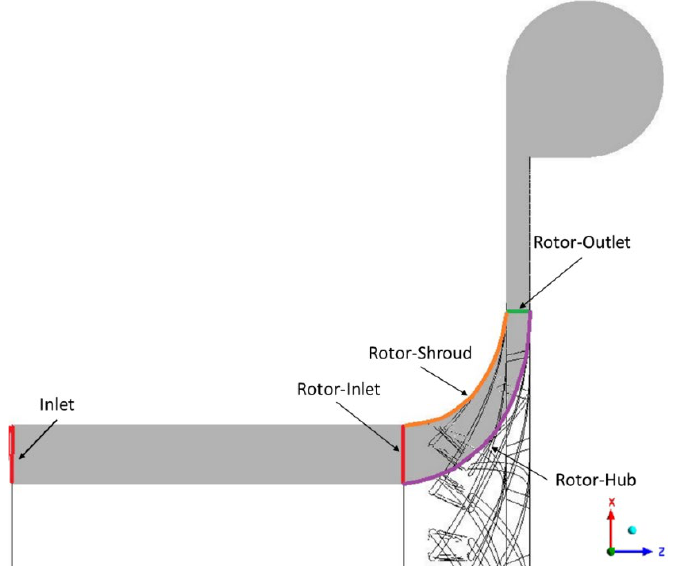
Figure 15. Schematic diagram of second stage compression meridian plane with R-513A refrigerant.